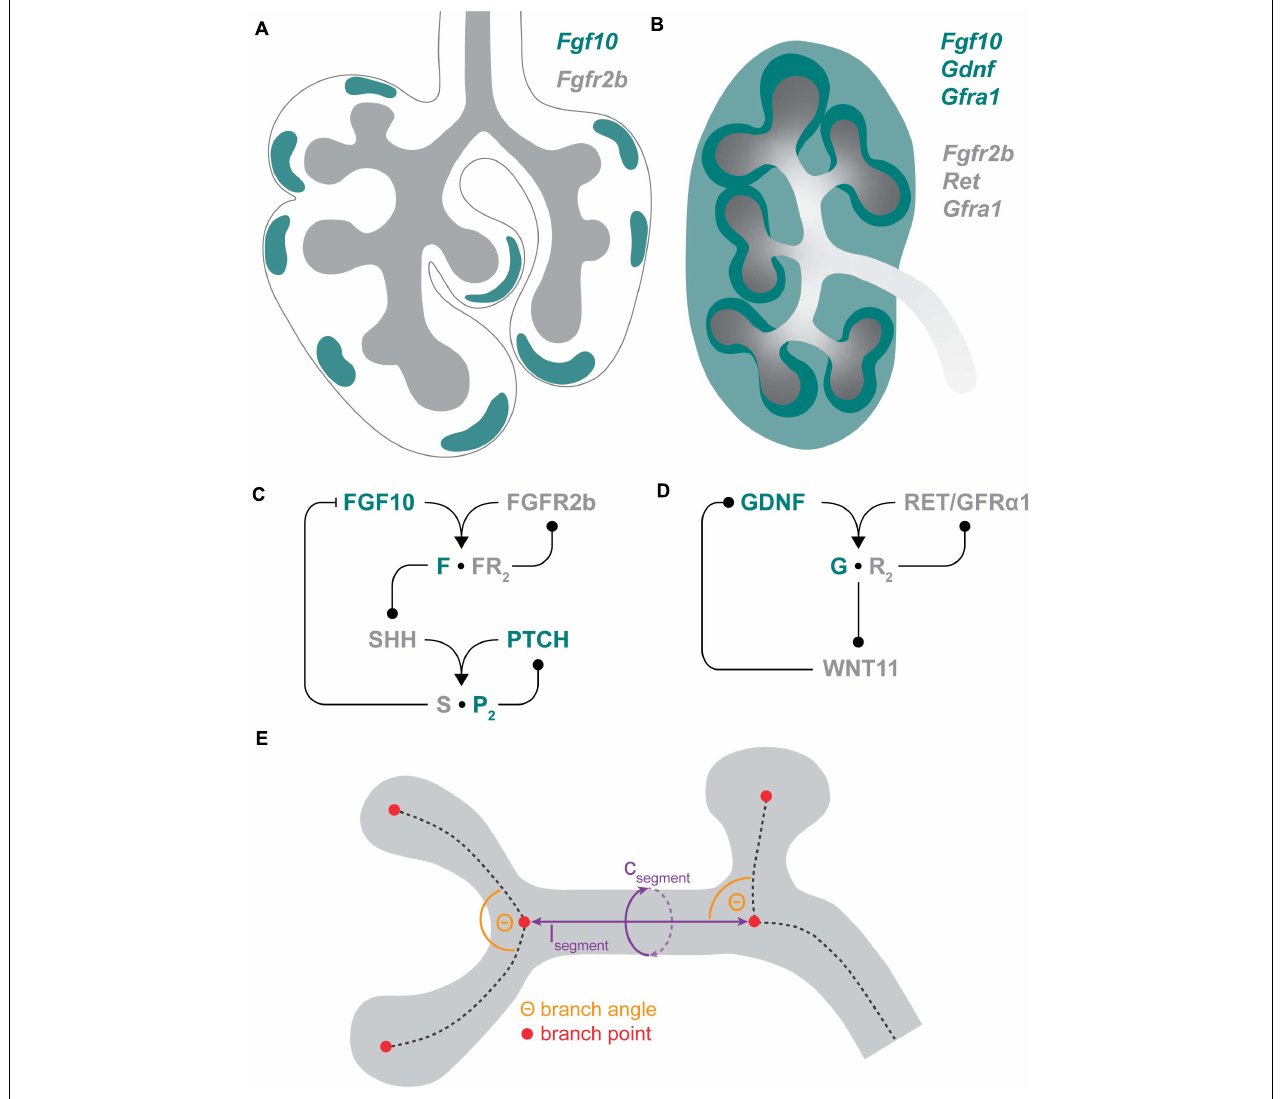
FIGURE 1 | Branching morphogenesis. (A) Gene expression domains of Fgf10 and its receptor Fgfr2b in the E11.5 mouse lung. Fgf10 is expressed in a spotty pattern in the submesothelial mesenchyme (green), while Fgfr2b is expressed in the epithelium (gray). (B) Gene expression domains of Gdnf and Fgf10 and their receptors in the E12.5 murine kidney. Gdnf is expressed in both the cap mesenchyme (dark green) and the stroma (light green), while Fgf10 is expressed in the cap mesenchyme. Fgfr2b is expressed in the ureteric bud (UB), while Ret expression is restricted to UB tips (dark gray). The Ret co-receptor Gfr α 1 is expressed both in the metanephric mesenchyme and the ureteric bud. (C) Core signaling network in lung branching morphogenesis. FGF10 signals via FGFR2b which enhances Shh expression. SHH signaling negatively regulates Fgf10 expression. (D) Core signaling network in kidney branching morphogenesis. GDNF signals via RET and GFR α 1 which enhances Wnt11 expression. WNT11 signaling positively regulates Gdnf expression. (E) Hallmarks of branching: The morphology of branched epithelial trees is governed by the branching mode/sequence (branch points; red), the length and circumference of branches (purple) and by the branching angle